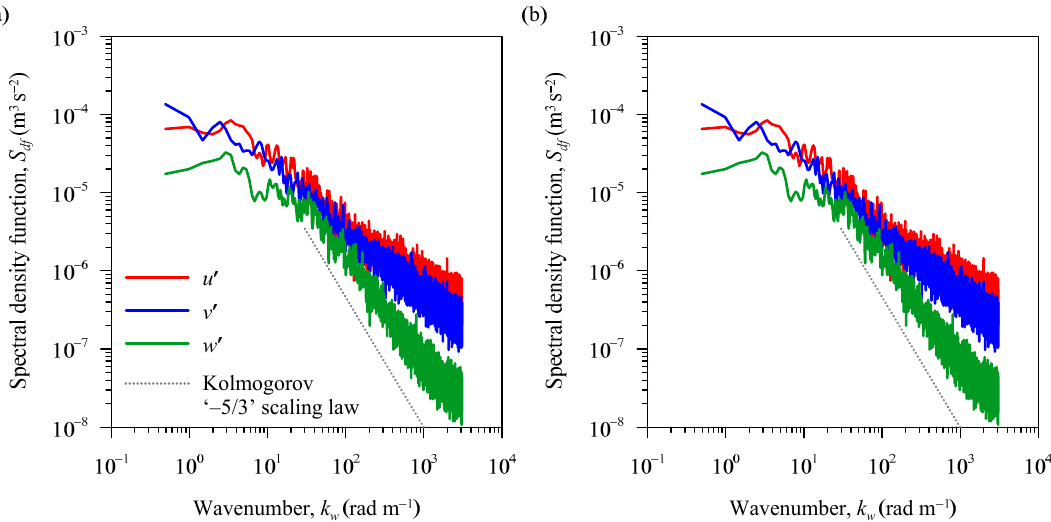
Figure 3. Spectral density function S df ( k w ) versus wavenumber k w ( a ) before and ( b ) after decontaminating the data in Run 1 at a relative streamwise distance x / L d = 0.7 and a relative vertical distance z / L d = 0.13.